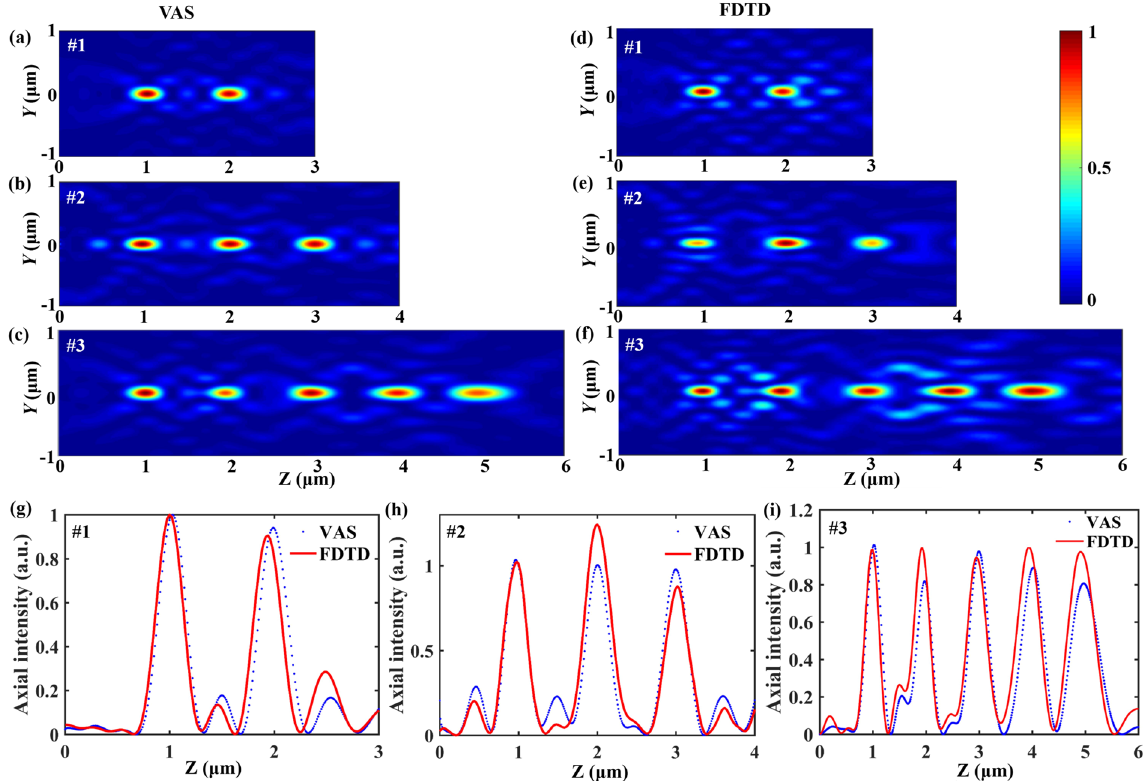
Figure 6. Comparison of the axial intensity distributions illuminated by LPB. ( a–c ) Show the normalized light intensity patterns of SOLs #1~#3 calculated by the VAS theory, respectively. ( d–f ) Show the normalized light intensity patterns of SOLs #1~#3 simulated by FDTD, respectively. ( g–i ) Show the comparison of the axial intensity distributions for SOLs #1~#3 calculated through the VAS theory (blue dot) and FDTD method (red solid line),